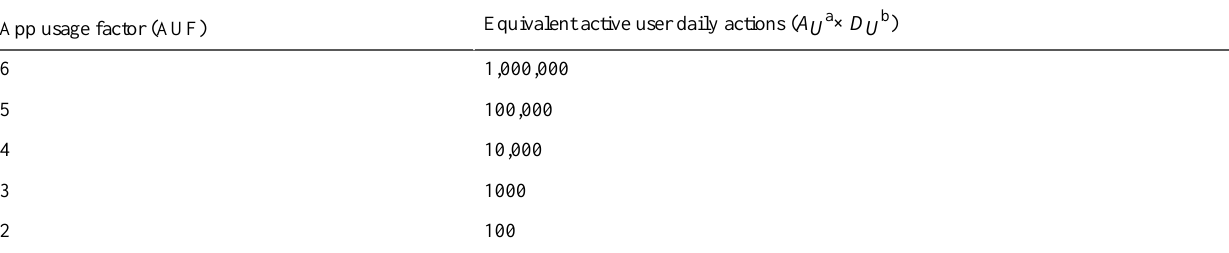
Table 4. Equivalent population impact of an app based on its corresponding